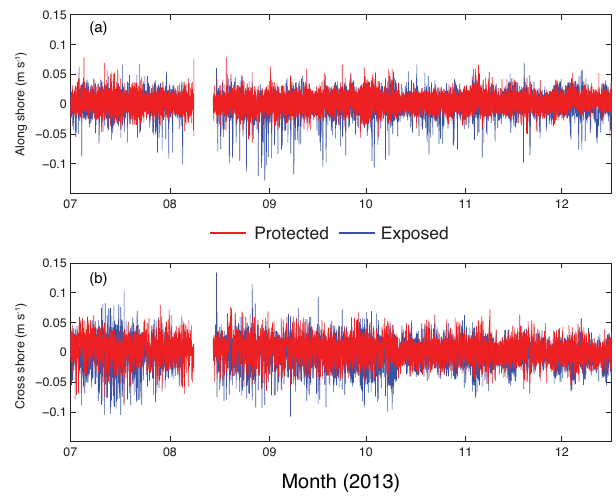
Figure 11. Depth-averaged (0–5ma.b.) bottom (a) alongshore and (b) cross-shore velocities from the Protected Mid and Exposed Mid acoustic Doppler current profilers collected from July to De- cember 2013. Positive alongshore velocity is 40 ◦ counterclockwise from north at Protected Mid and 13 ◦ counterclockwise from north at Exposed Mid. Positive cross-shore velocities are 90 ◦ clockwise from positive alongshore velocities